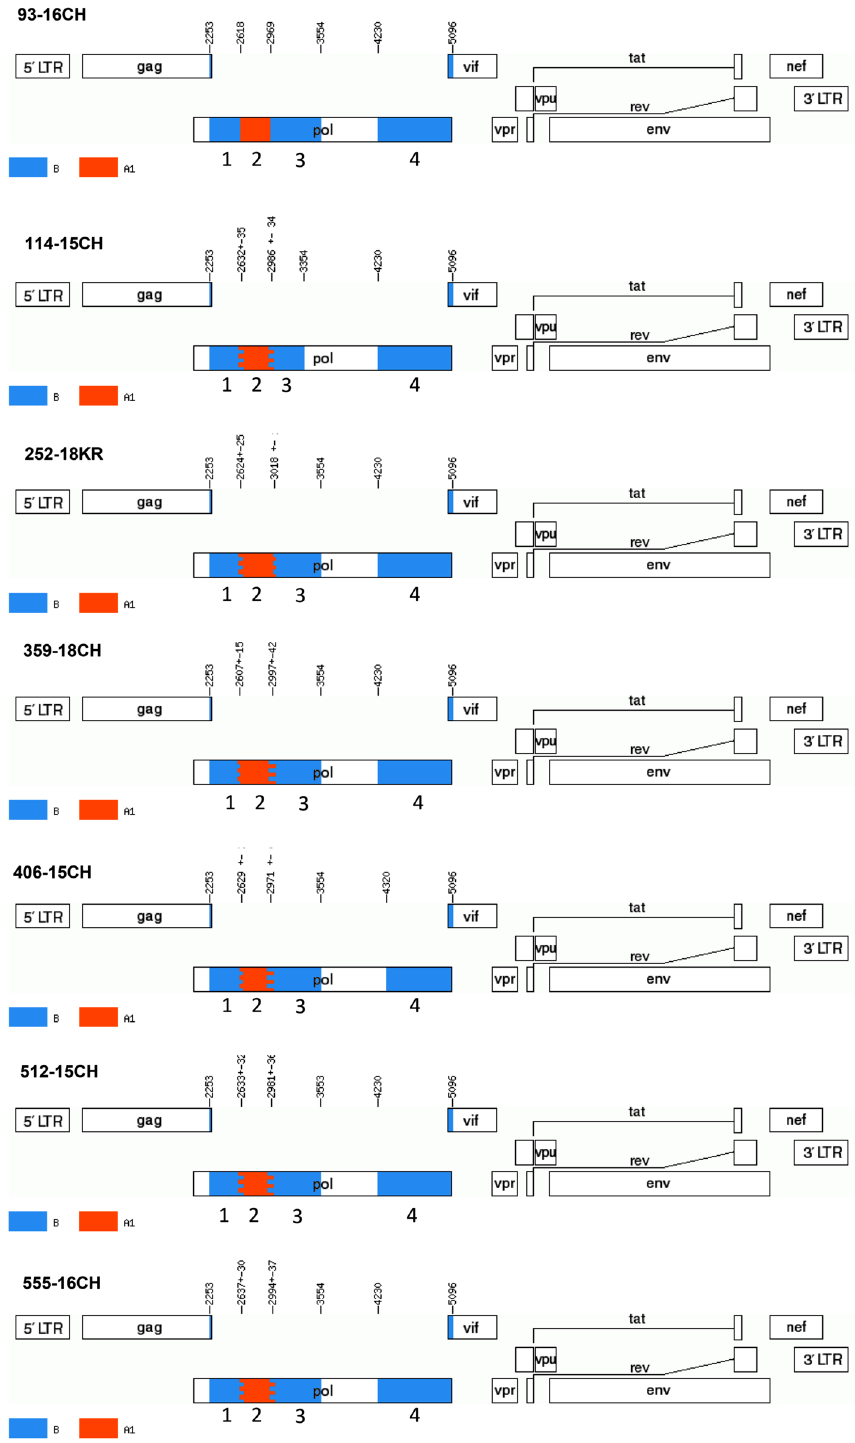
Figure 7. Recombination pattern of the seven partial HIV-1 pol sequences from the identified A1B Cluster. Analysed region include the protease with a fragment of the reverse transcriptase gene (2253–3554 bp) and the integrase gene (4230–5096 bp). Recombination breakpoints (according to HXB2 genome positions) were obtained using Simplot v3.5.1 software and jumping-profile hidden Markov model (jpHMM). The blue color stands for HIV-1 subtype B and red color stands for sub-subtype A1. Component subtype regions are labeled from 1 up to 4 on the genome map, corresponding with numbered on phylogenetic trees in Supplementary Figure S7. The mosaic map was generated using the Recombinant HIV-1 Drawing Tool (https:// www. hiv. lanl. gov/ conte nt/ seque nce/ DRAW_ CRF/ recom_ mapper.